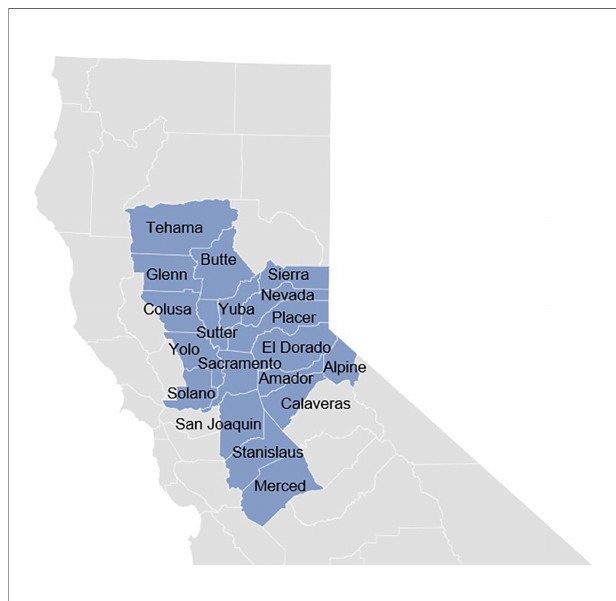
FIGURE 1 | UC Davis Cancer Center 19-County Catchment